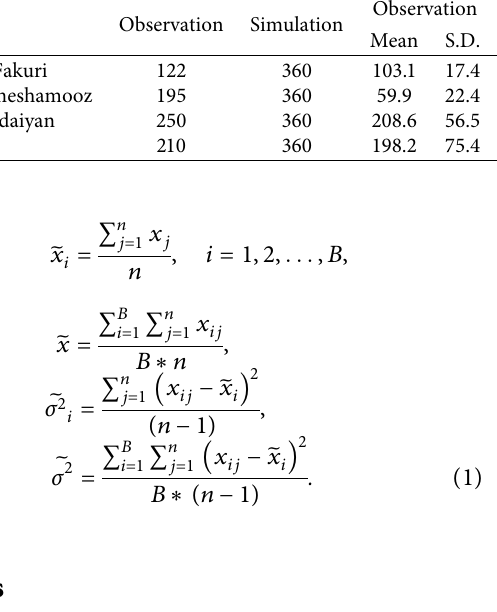
Figure 6: Exemplifcation of the studied signalized intersections in Aimsun environment and the real world. (a) Kooshesh-Fadaiyan. (b) Table 5: Validation of simulation model’s vehicle travel times through the study intersections. Sample size (number) Travel time (second) Variation test (Levene) Mean test ( t -test) Intersection Observation Simulation